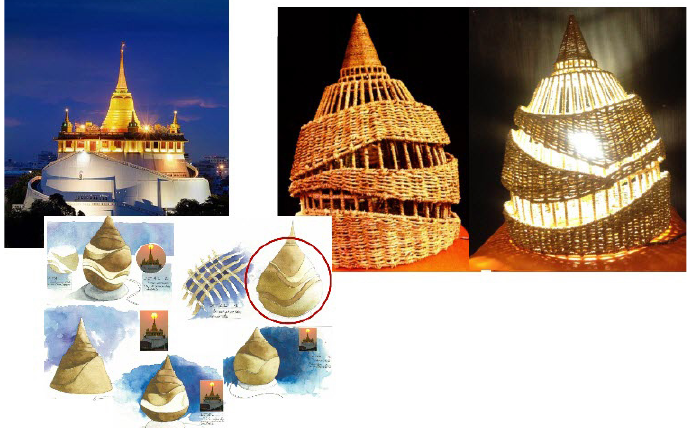
Figure 1. Group 1 design work inspired by Wat Saket (source: created by author) Group